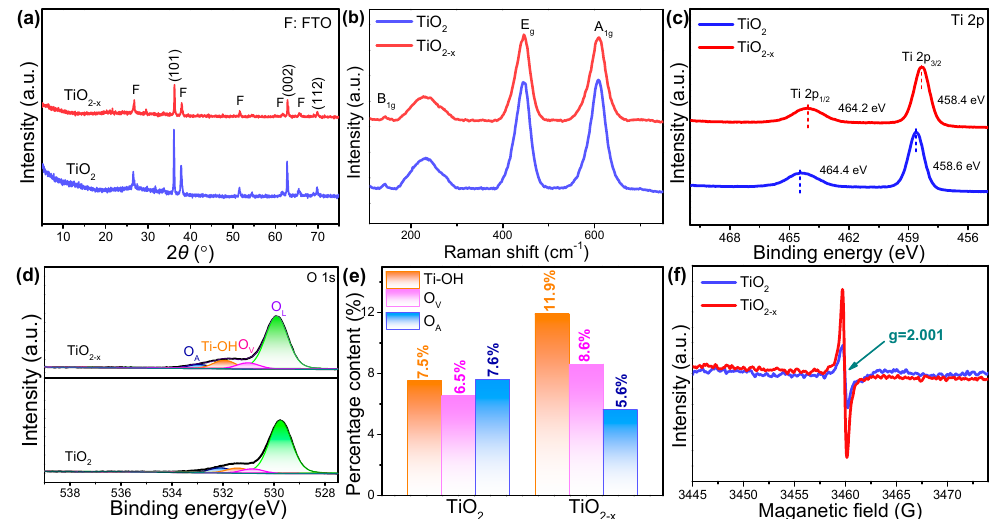
Figure 2. ( a ) XRD patterns and ( b ) Raman spectra of TiO 2 and TiO 2-x ; XPS spectra of ( c ) Ti 2p, ( d ) O 1s of TiO 2 and TiO 2-x ; ( e ) relative content of oxygen vacancy, Ti − OH, and adsorbed oxygen groups in the TiO 2-x photoanodes; ( f ) EPR curves of TiO 2 and TiO 2-x . The PEC properties of the TiO 2 and TiO 2-x electrodes were monitored in a typical three-electrode system using 1 M NaOH as the electrolyte. The photocurrent densities of TiO 2-x with different NaBH 4 reduction times were compared to investigate the effect of